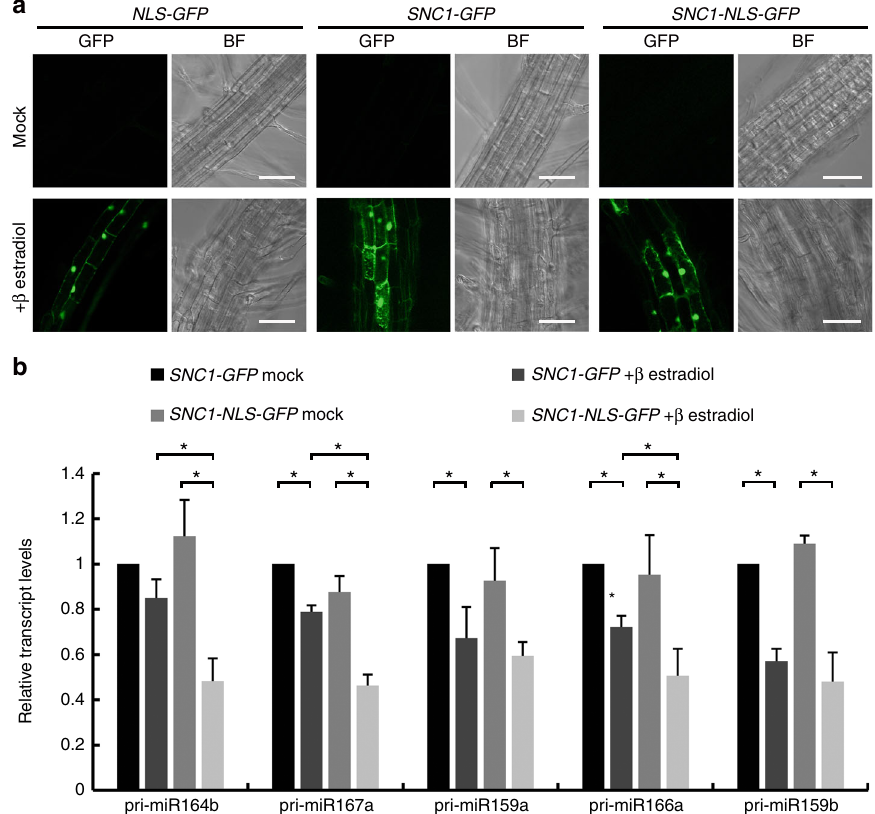
Fig. 5 Induced SNC1 nuclear accumulation is suf fi cient to inhibit MIR gene expression. a NLS-GFP , SNC1-GFP , and SNC1-NLS-GFP transgenic seedlings were treated with DMSO (mock) or 50 μ M β -estradiol (dissolved in DMSO). GFP fl uorescence was detectable in roots of β -estradiol-treated but not mock- treated plants. BF bright fi eld. Bar = 50 μ m. b Relative levels of fi ve pri-miRNAs in SNC1-NLS-GFP and SNC1-GFP after 6 h of mock and 50 μ M β -estradiol treatment as determined by real-time RT-PCR. Error bars represent standard deviations calculated from three biological replicates ( * Student ’ s t test: P < 0.05). Source data are provided as a Source Data fi